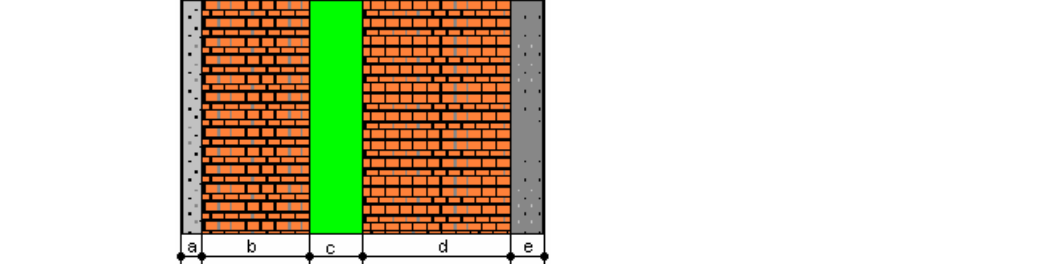
Table 2. Thickness, thermal conductivity, and thermal resistance values of the materials used in building design.